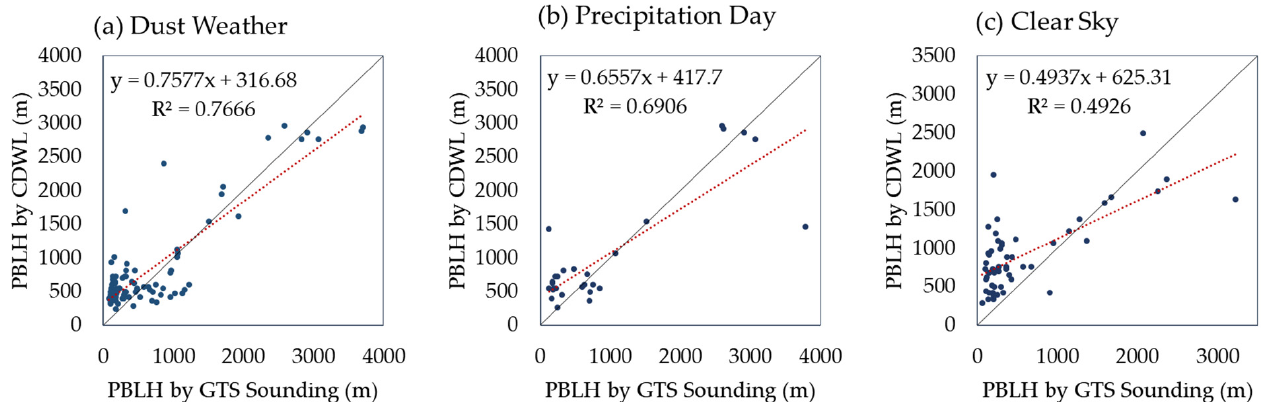
Figure 7. Comparison of CDWL and GTS sounding PBLH inversion results for ( a ) dusty weather, ( b ) precipitation, and ( c ) clear skies in the effective height range. Also shown is the regression line (red line) and reference line y = x (black line).